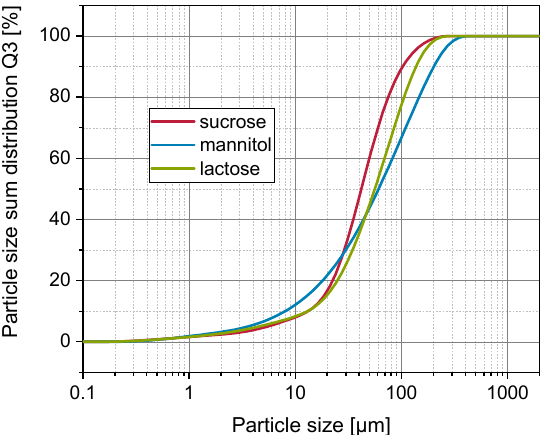
Figure 1. Particle size distribution of soluble carrier materials measured by means of laser diffraction (Mastersizer 3000, Malvern Panalytical, Malvern, UK) applying dry dispersion at 4 bar air pressure.